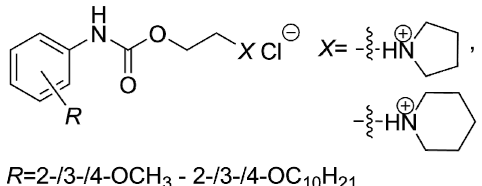
(Figure 4), against M. tuberculosis H 37 R v , M. kansasii CNCTC My 235/80, M. avium CNCTC My 330/88 and M. kansasii 6509/96, respectively.